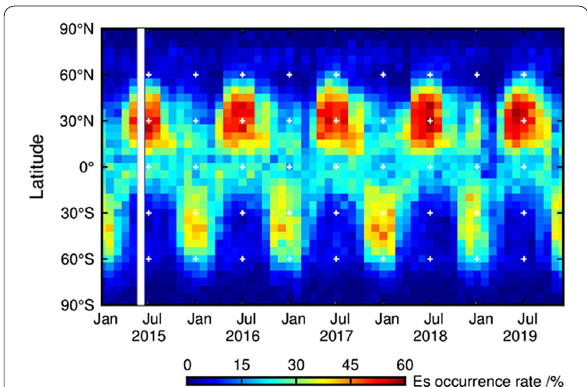
Fig. 4 Time series of the FY-3C RO-derived Es-layer occurrence rates during Jan. 2015 to Dec. 2019, with a resolution of a 5° latitude 1-month grid Fig. 7 The local time distribution of FY-3C GPS × RO events number during Jan 2015 to Dec